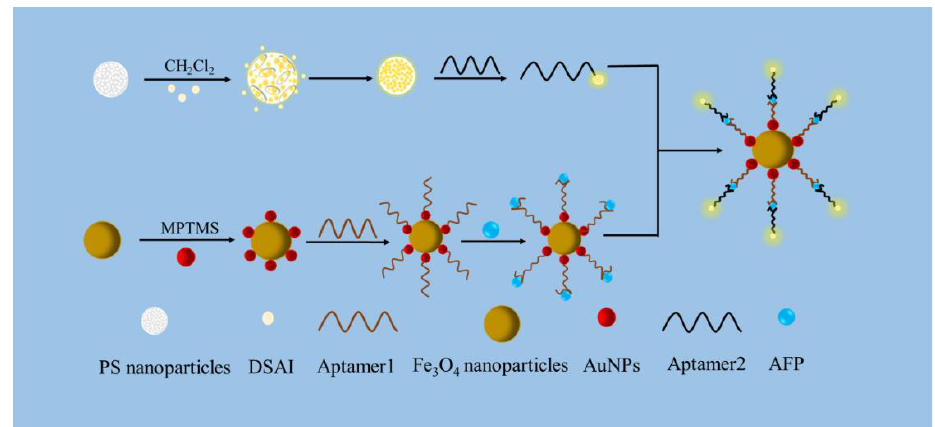
Figure 1. Schematic of alpha-fetoprotein detection by the sandwich structure of aptamer combined with ferromagnetic composite particles labeled with AIEgen nanospheres.